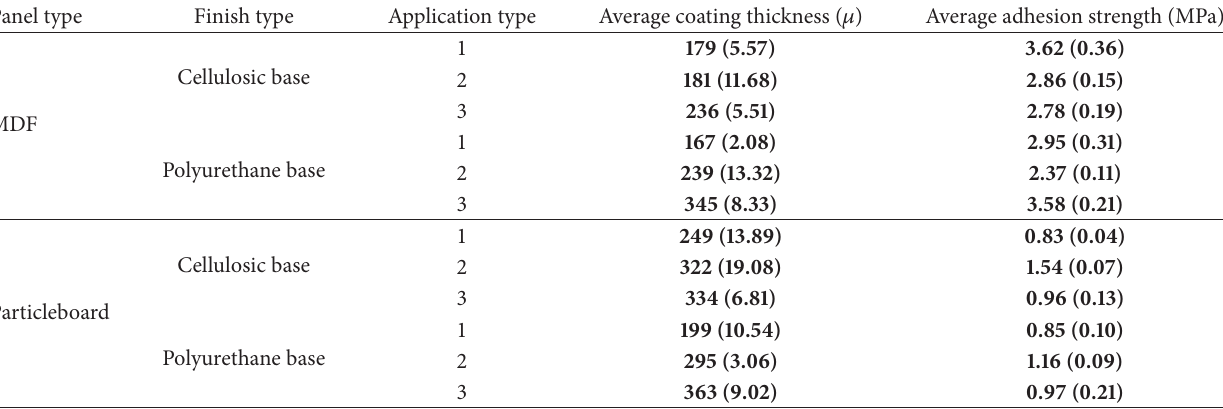
Table 3: Average coating thickness and adhesion strength values of the